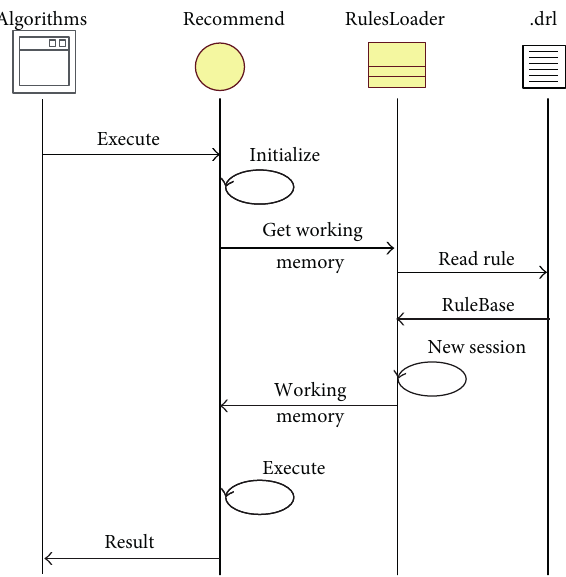
Figure 11: The Drools operation in the X73 Sink